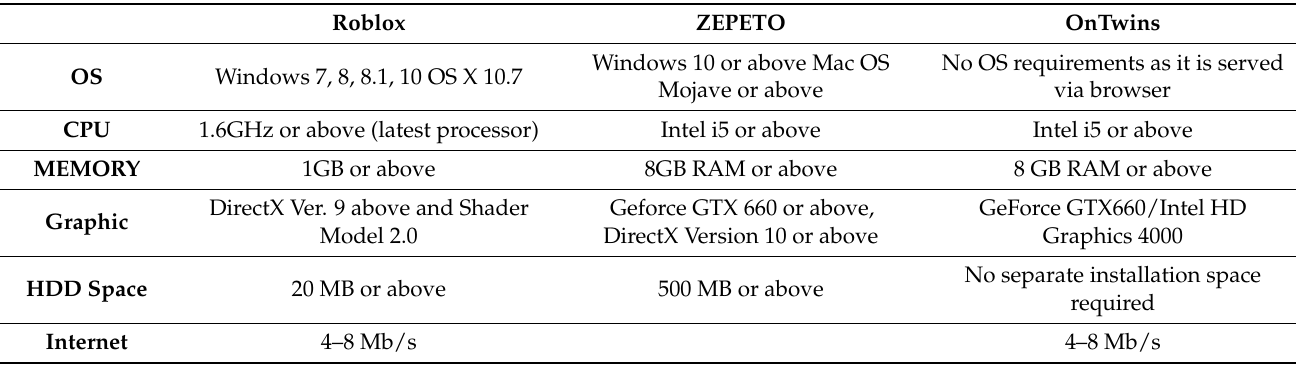
Table 5. Compare System Requirements.